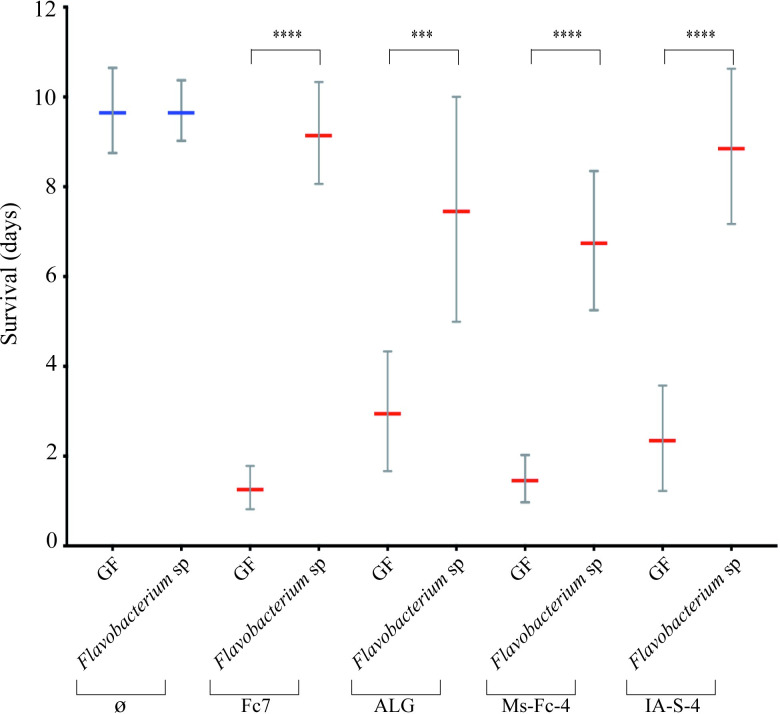
Strain 4466 provides full protection to gnotobiotic rainbow trout larvae against infection by four strains of F. columnare.Flavobacterium sp. Survival of GF trout larvae exposed to Flavobacterium sp. strain 4466 48 h before infection with F. columnare strains Fc7, IA-S-4, Ms-Fc-4 and ALG-00-530. All F. columnare strains rapidly killed GF fish, whereas trout larvae that were re-conventionalized with Flavobacterium sp strain 4466 survived to all strains of F. columnare. Mean and SD plot representing average day post-infection at which infected fish died. For each condition n = 10 larvae. All surviving fish were euthanized at day 10. Asterisks indicate significant difference from non-infected population (****p<0.0001).